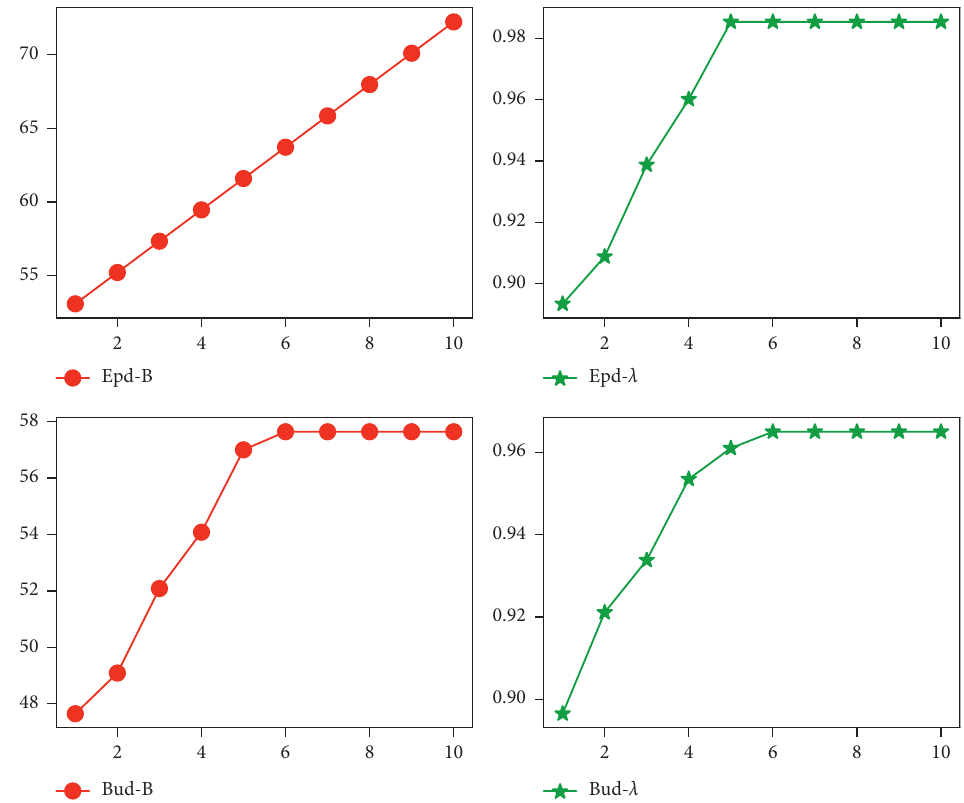
Figure 1: Fluctuation of cost B and utility λ under different uncertain parameters in case